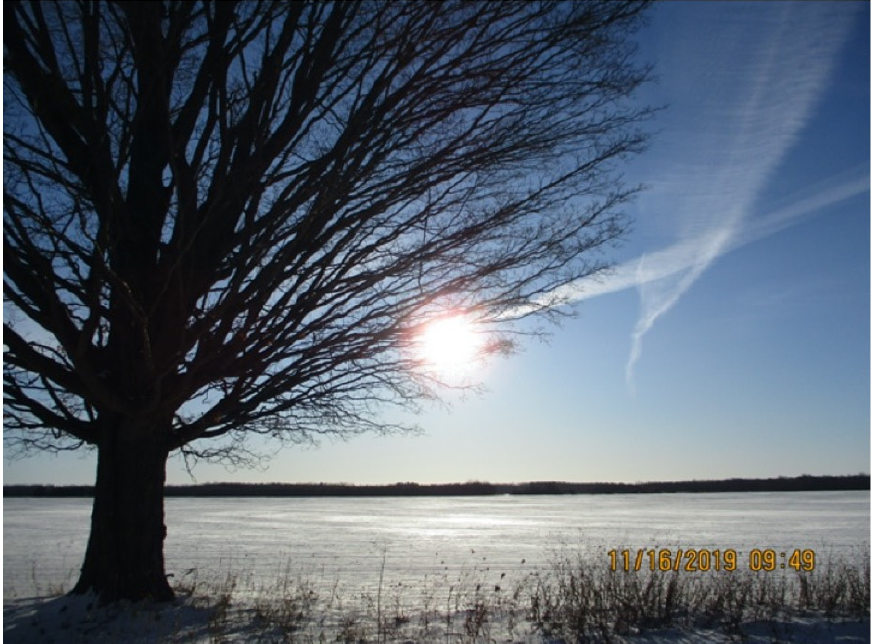
Figure 2. “A New Day.” The participant sees each day as a new beginning. The branches remind her of painful memories that we all carry with us, and the sun is shining through. We need to focus on the beauty that surrounds us.